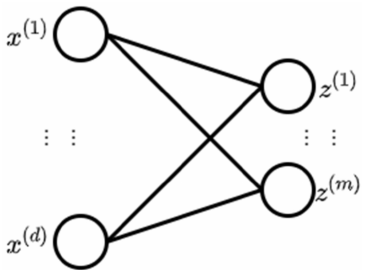
Figure 2. Restricted Boltzmann machine (RBM) (adopted from [34]).